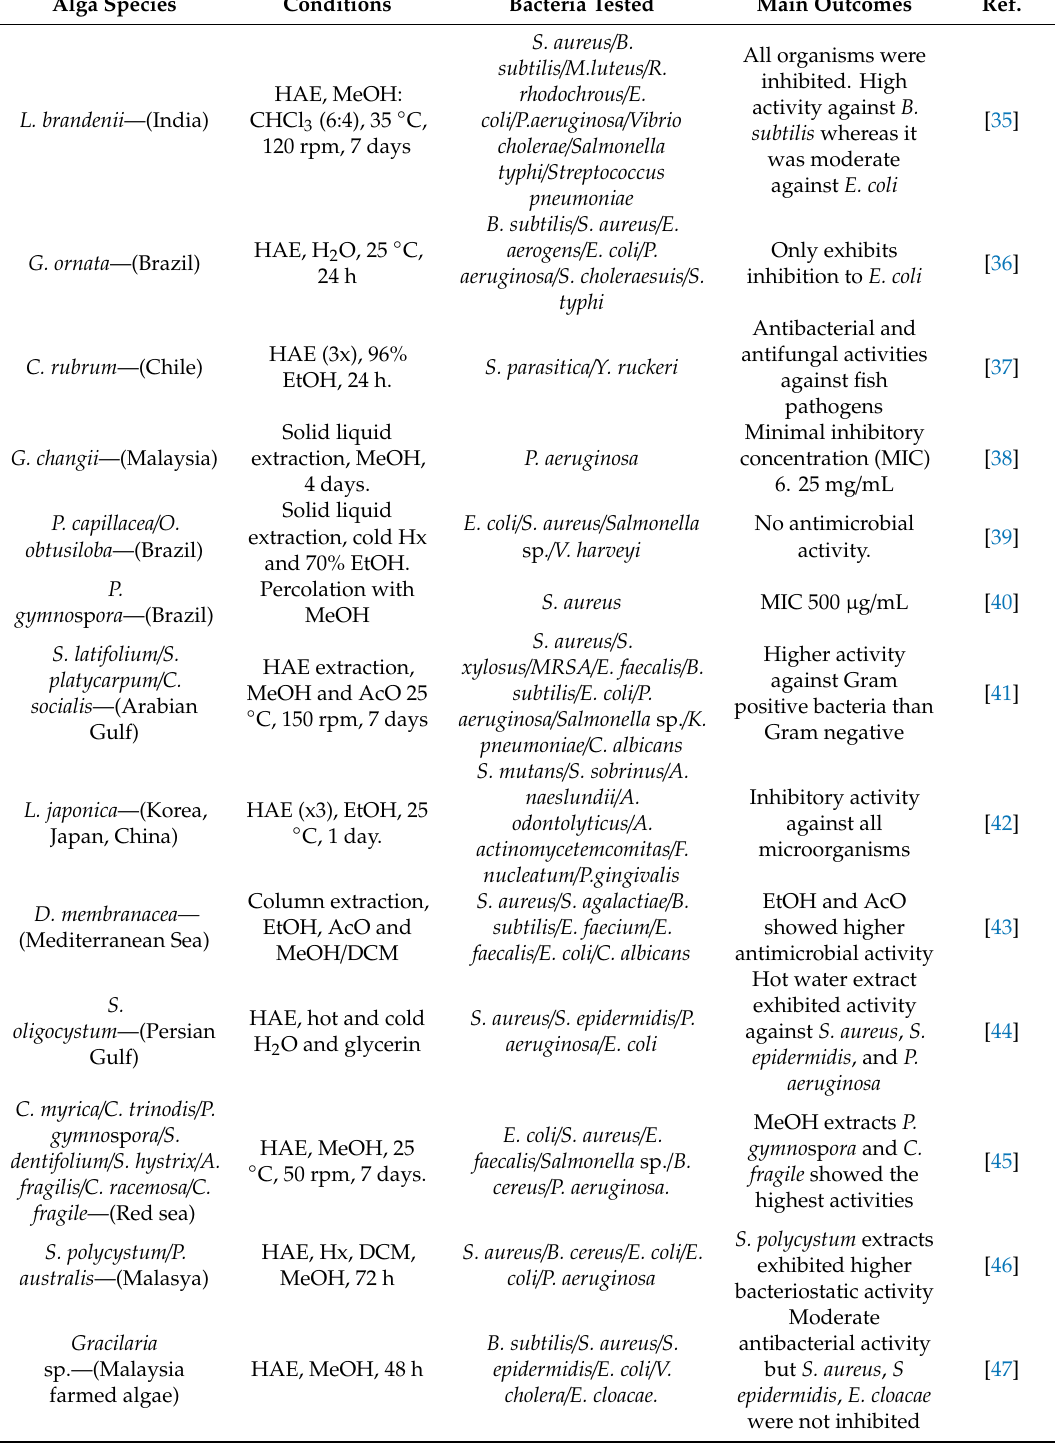
Table 1. Antimicrobial activity of algae crude extracts obtained using classic extraction technologies from 2010 to